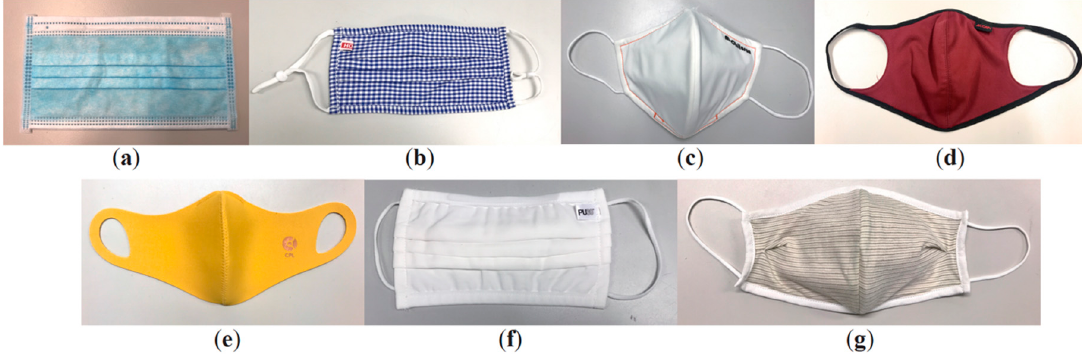
Figure 1. Images of ( a ) Sample A, ( b ) Sample B, ( c ) Sample C, ( d ) Sample D, ( e ) Sample E, ( f ) Sample F, and ( g ) Sample G.